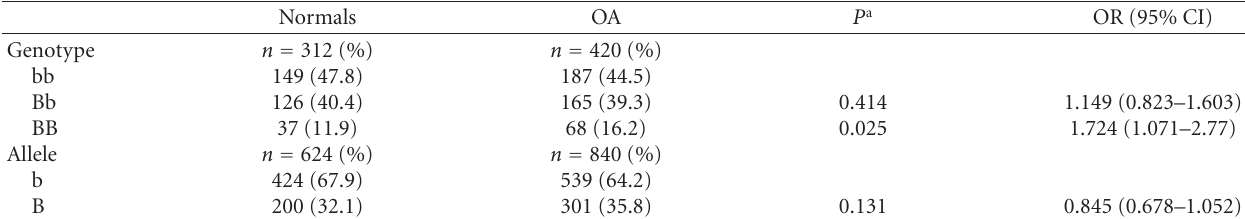
Table 2: Genotype and allele frequencies and odds ratios of MATN3 SNP6 (rs8176070) in control, osteoarthritis cases. Normals